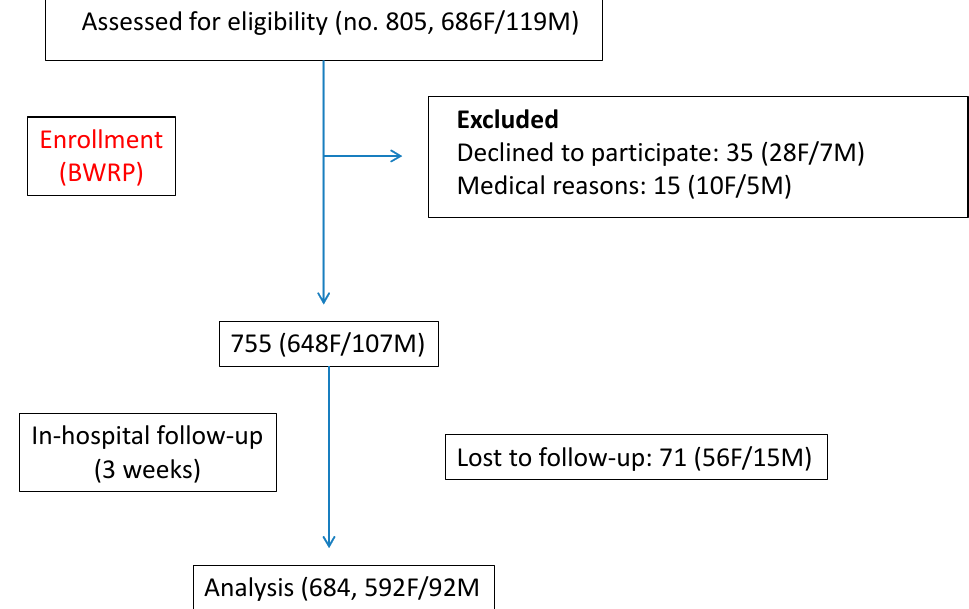
Figure 1. Consort flow diagram of the study. BWRP, body weight reduction